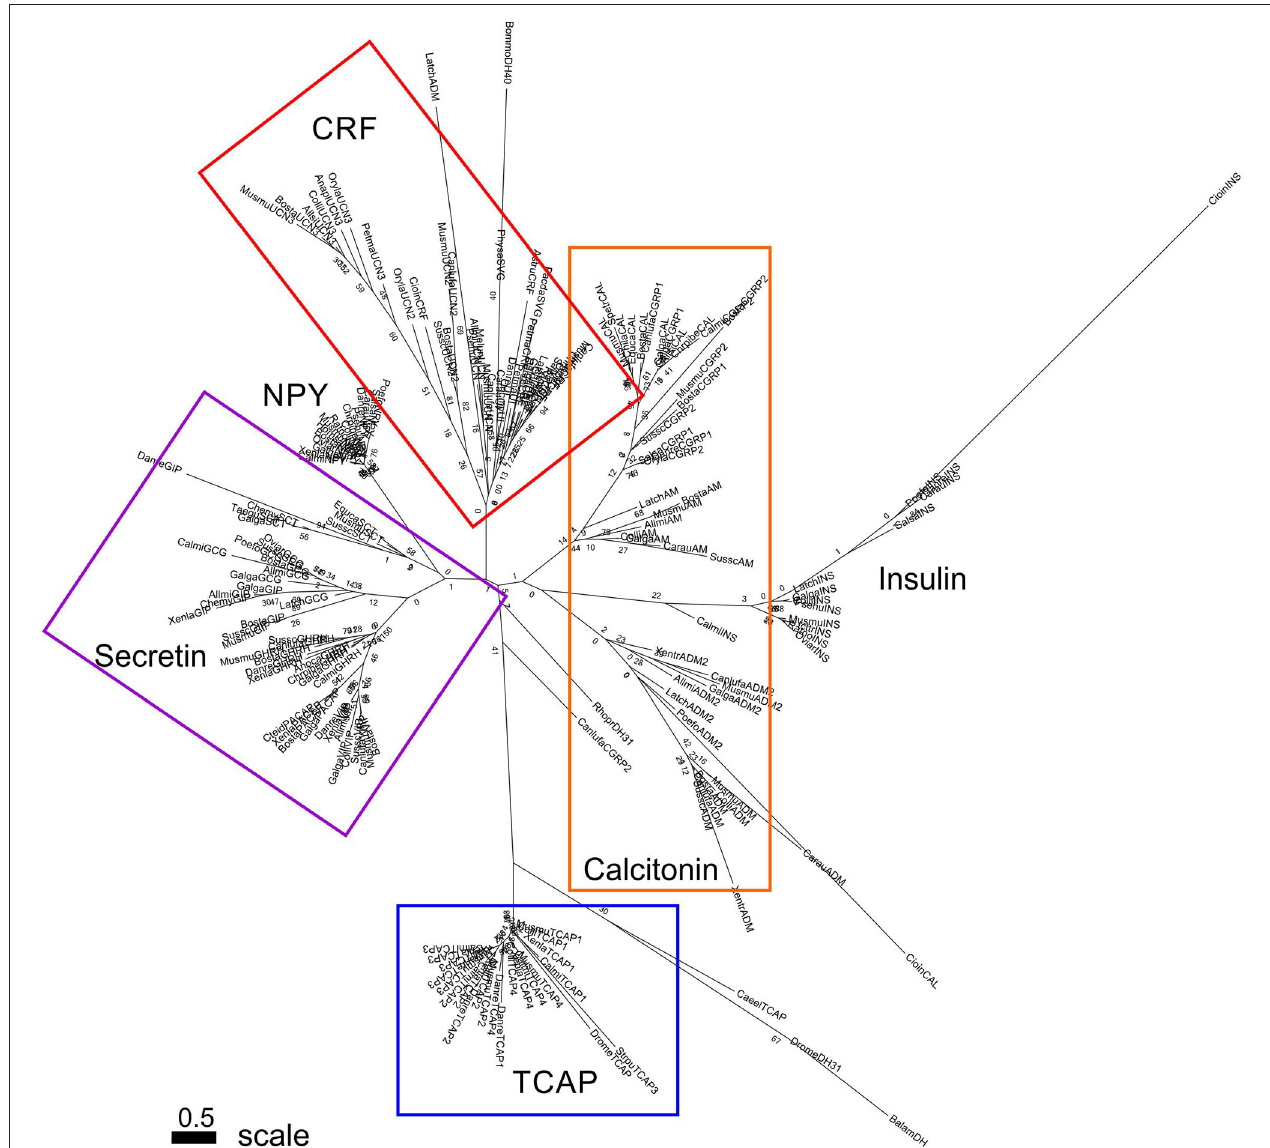
FIGURE 4 | Phylogenetic analysis of insulin, calcitonin and TCAP mature peptides (rooted to TCAP). Each family is highlighted with a different color: calcitonin (orange), insulin (green), TCAP (blue). Analysis was conducted using the maximum likelihood method based on the JTT matrix-based model (lnL = − 919.2846; + G, parameter = 6.6766) (41) Initial trees for the heuristic search were obtained by applying the NJ method to a matrix of pairwise distances estimated using a JTT model. Branch lengths represent the number of substitutions per site, with the tree shown to scale. Bootstrap analysis involved 1,000 replicates. Calcitonin family: CALC, calcitonin; CGRP1, calcitonin-gene-related peptide 1; CGRP2, calcitonin-gene-related peptide 2; AM, amylin; ADM, adrenomedullin; ADM2, adrenomedullin 2; Insulin: INSa, insulin A chain; INSb, insulin B chain; Outgroup: TCAP, teneurin C-terminal associated peptide. The scale bar indicates the level of magnification for the